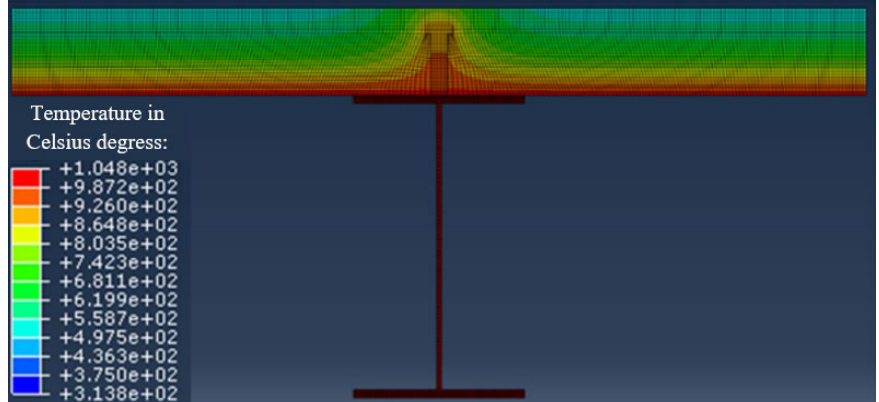
Figure 6. Temperature field ( o C), in 120 minutes of fire duration, of the composite beam 1